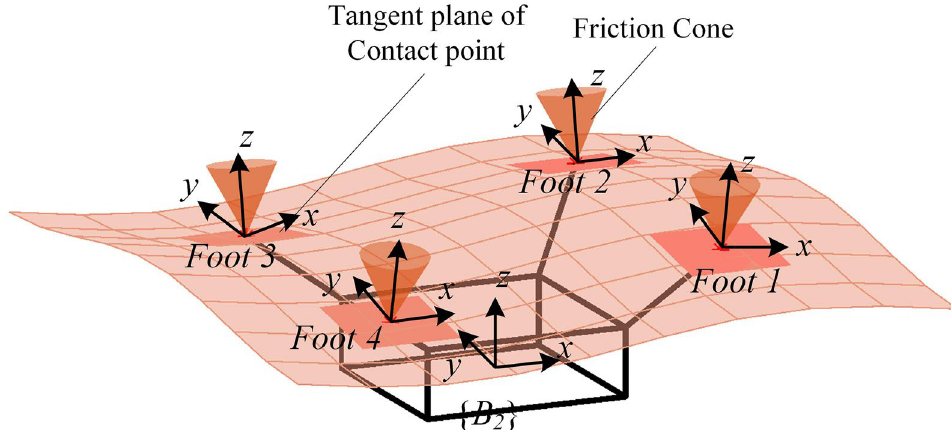
Figure 7 Friction cone constrains located at the contact